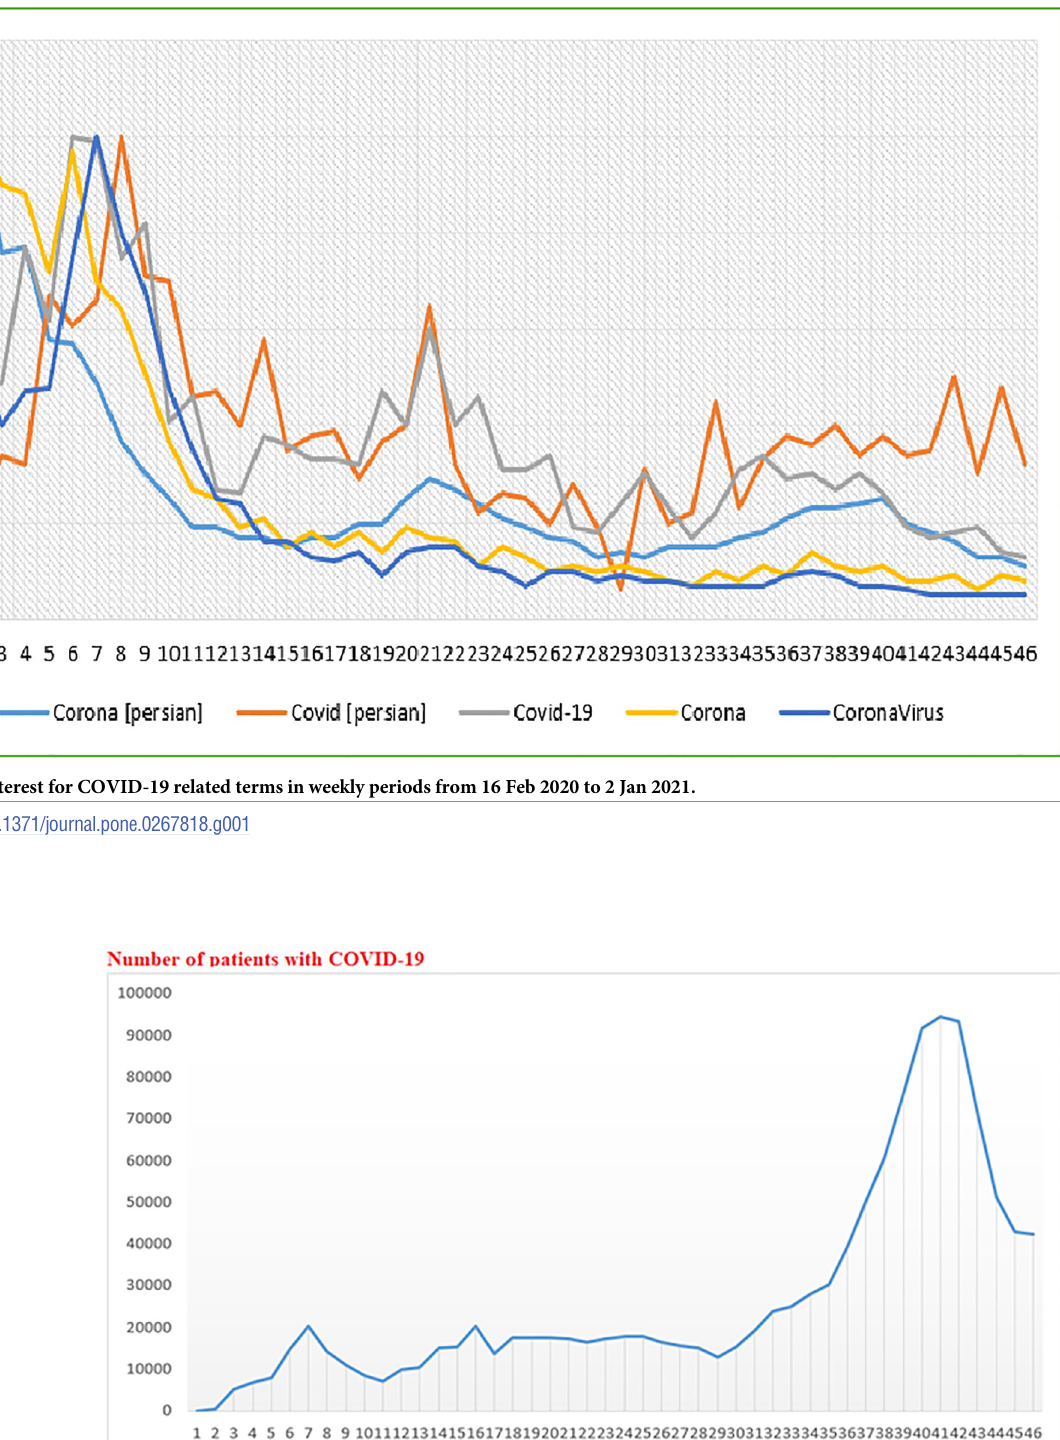
PLOS ONE | https://doi.org/10.1371/journal.pone.0267818 July 26, 2022 5 /